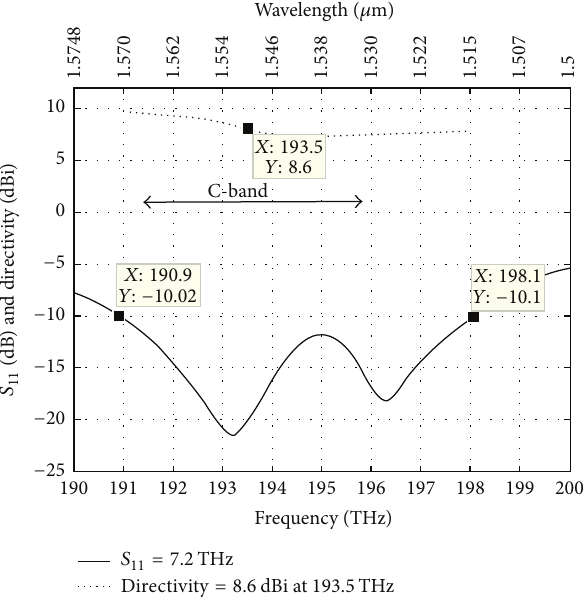
Figure 6: Return loss 𝑆 11 (solid line) and directivity (dotted line) of proposed